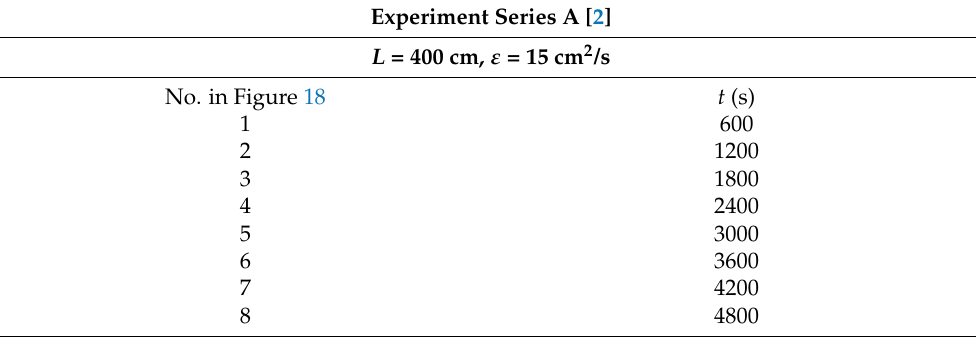
Table 6. Spatial and temporal scales of the delta in the experiment of